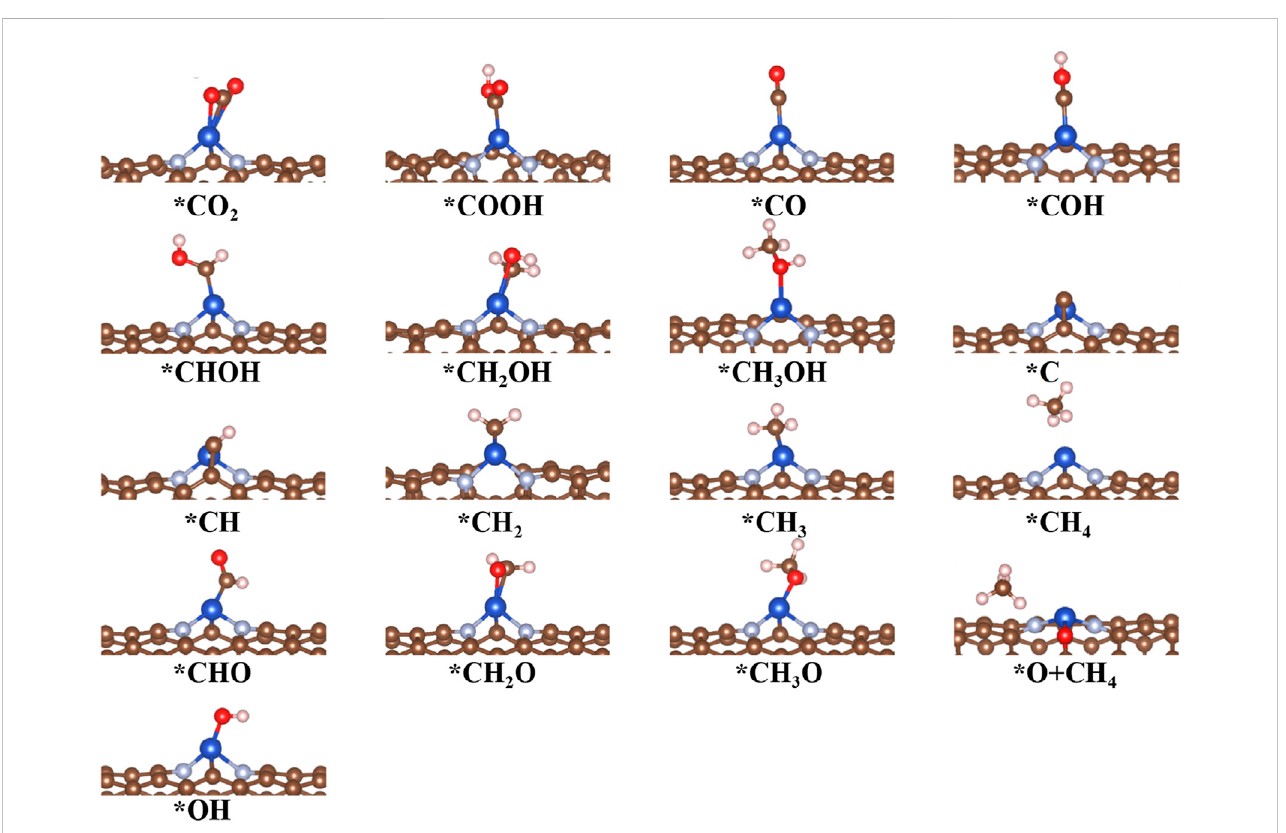
Optimized structures of intermediates for CO 2 RR on Cu@CNT surfaces.